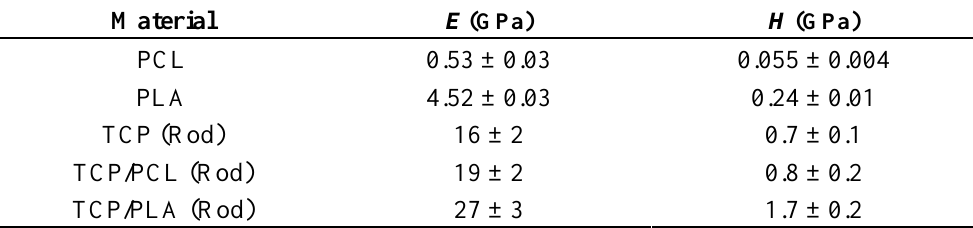
algorithm assumes an infinite scaffold-infiltrate interfacial strength. The following boundary conditions were selected: the two bottom contact cylinders were fixed while the top ones are free to move under a concentrated load in the direction perpendicular to the rod axes. Table 1. Elastic modulus and Vickers hardness determined from instrumented indentation for the individual polymers and the robocast structure rods, before and after polymer infiltration. Average values are shown with standard deviations as